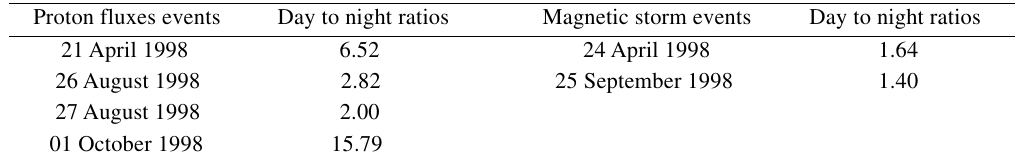
Table III. Day to night ratios for proton fluxes and magnetic storm events calculated choosing (cid:114) = 90 ° (sunrise) and (cid:114) = 96° (sunset).